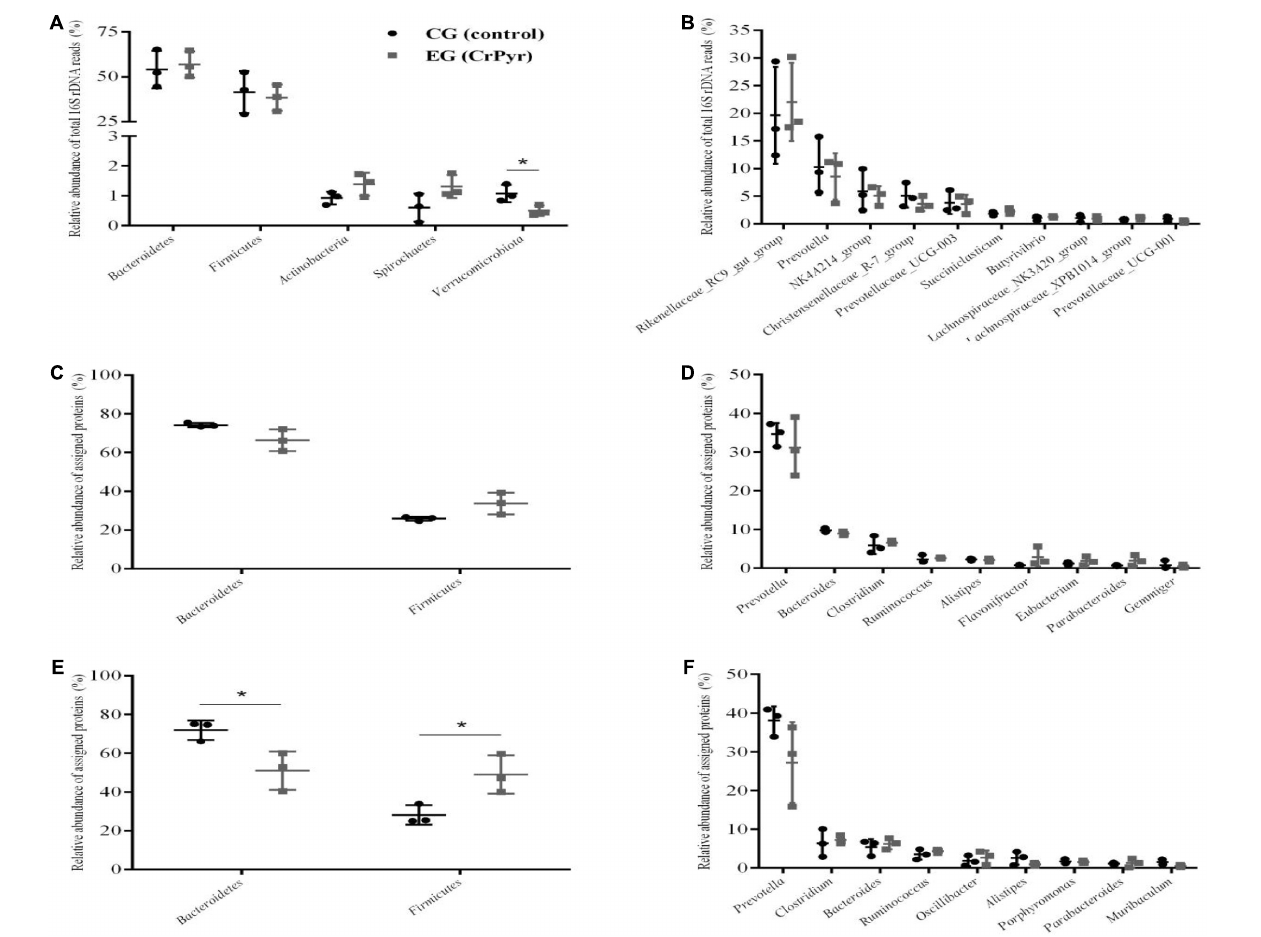
FIGURE 4 | Phylogenetic classification and metaproteomics analyses of rumen fluid microbiota of beef cattle fed a CrPyr supplementation diet. (A,B) show phylum-level (A) and genus-level (B) rumen fluid community composition based on Illumina sequences of 16S rDNA amplicons (V3–V4 region). (C,D) show relative abundances of total identified proteins in rumen fluid assigned to bacterial phyla (C) and genera (D) . (E,F) show relative abundances of differentially expressed proteins in rumen fluid assigned to bacterial phyla (E) and genera (F) . CG, control group; EG, experimental group, diet supplemented with 60 g/day CrPyr. n = 3 per group. * P <